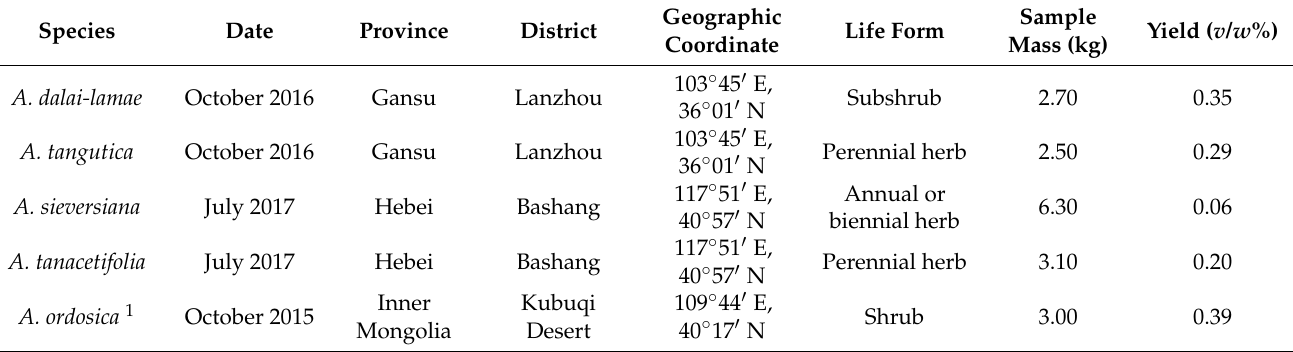
Table 2. Collecting information of the five Artemisia species.